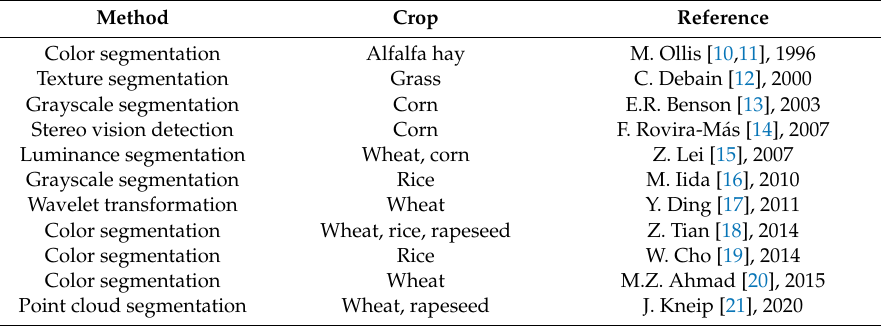
Table 1. Current research status of the harvester vision